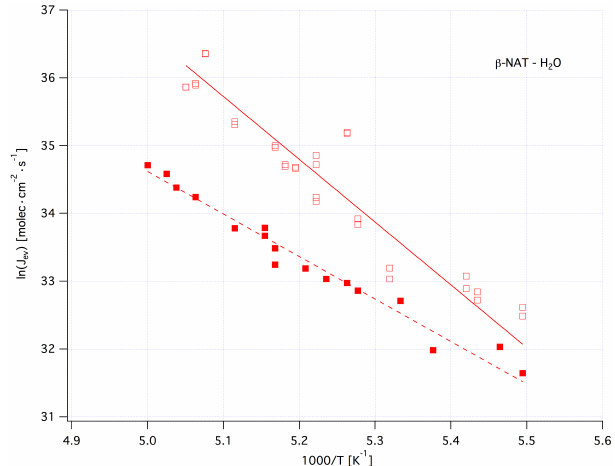
Figure 12. Arrhenius plot of J ev (H 2 O) for β -NAT data displayed in Fig. 4b. Full and empty red squares represent results of PV and TO experiments, respectively. The equations for the linear fits may be found in the